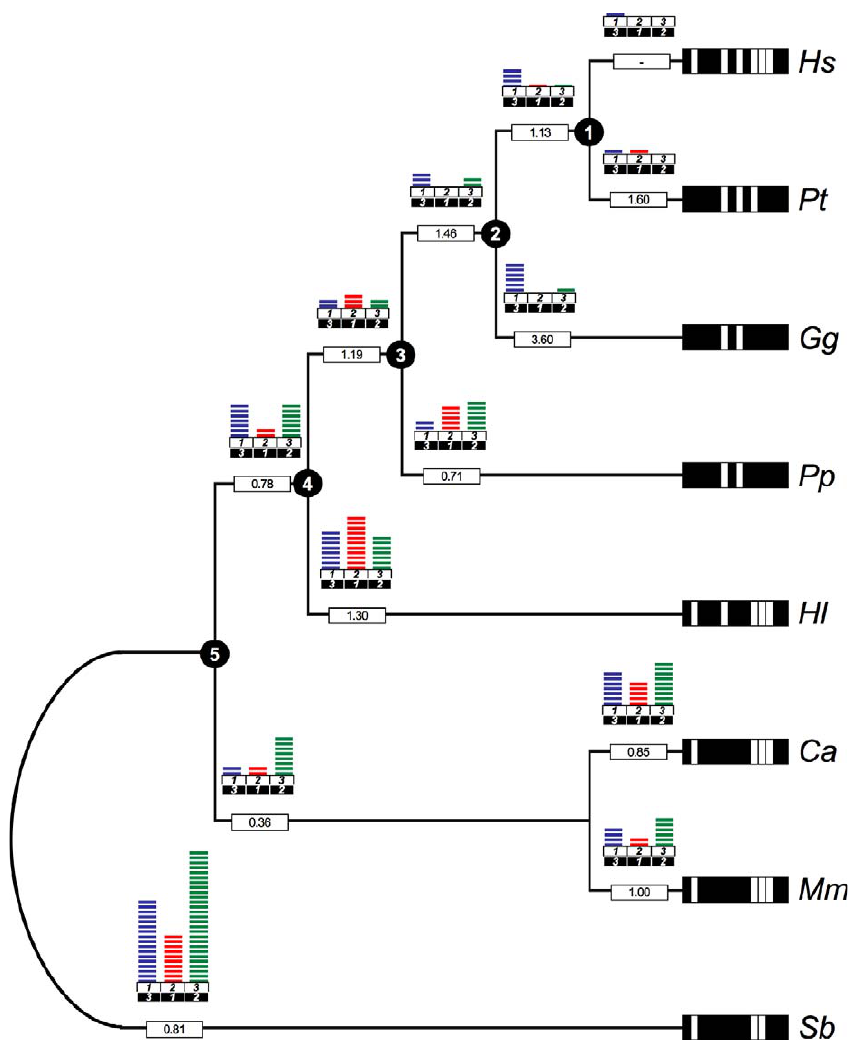
Figure 2. Evolutionary Oscillation between XL a s and ALEX Frames Revealed from Nucleotide Substitution Analysis The ratio of maximum likelihood estimates of nonsynonymous rates between the two frames ( XL K A / ALEX K A ) is shown on each branch. A series of colored bars above each branch shows the number of nucleotide substitutions at each codon position reconstructed using parsimony. Each bar represents a single substitution. The codon positions are numbered as follows: black letters on white background (XL a s frame); white letters on black background (ALEX frame). Boxes at the ends of external branches show repeat structure of the XL-exon in each species (white ¼ deletion). Species abbreviations are as in Figure 1. DOI: